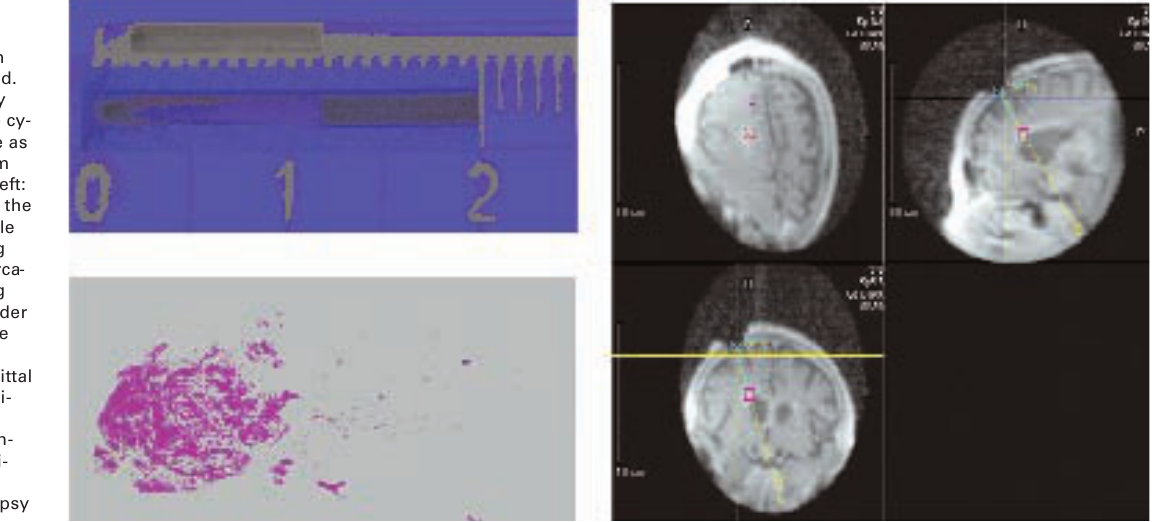
Top left: detail of the tip of the brain biopsy needle used. Inset: same biopsy needle with tissue cy- linder still in place as seen under 440 nm UV light. Bottom left: histology (PAS) of the same tissue sample as above, showing the tumour demarca- tion line, matching what was seen under UV light. Right: the intraoperative MR images (axial, sagittal and coronal gadoli- nium-enhanced T1 sequences) demon- strate a 4 mm peri- ventricular lesion and the biopsy needle in